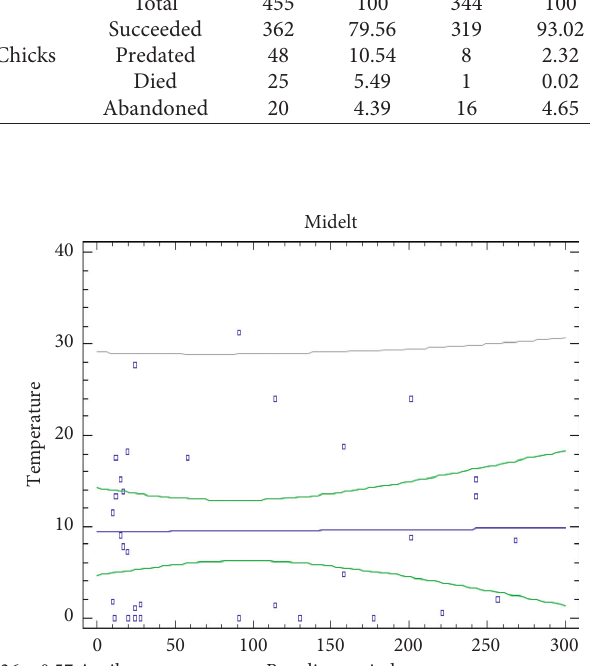
Figure 2: GLMM predicting the cold temperature avoidance of turtle doves at Midelt (breeding periods far from lowest temperatures).